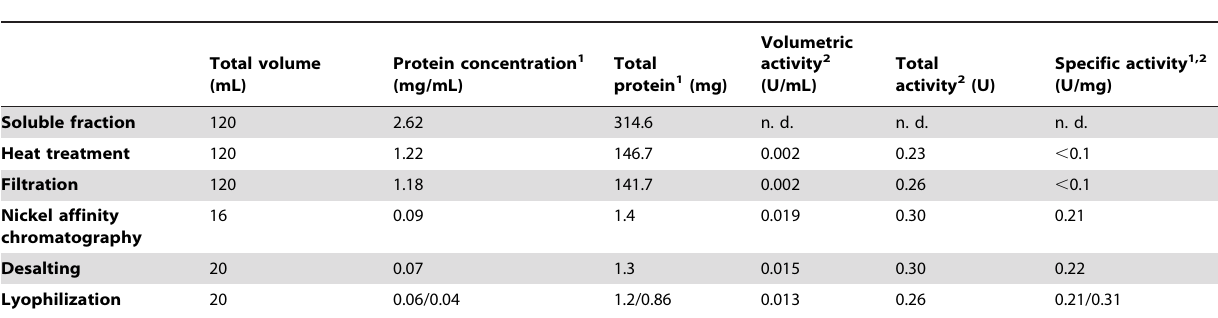
Table 2. Purification of soluble Ta AlDH from 10 g of E. coli cells produced in 1 L of fed-batch